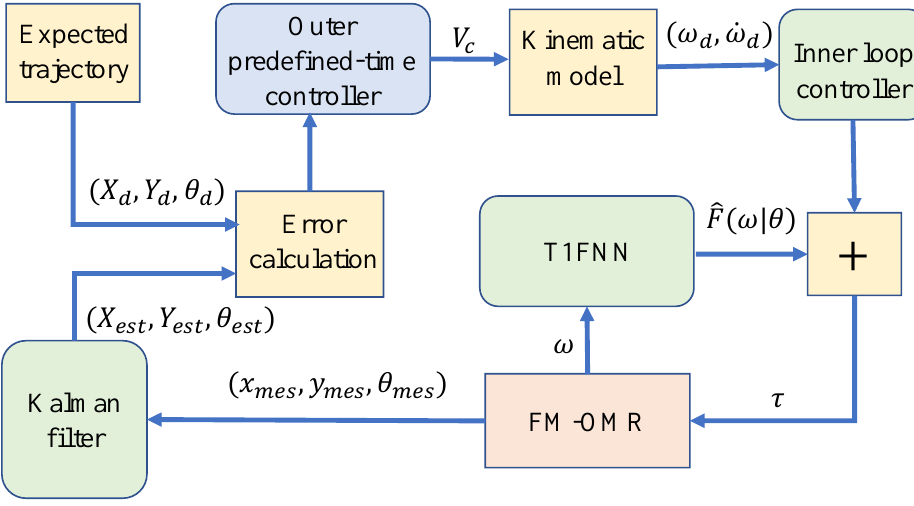
Figure 3. Control structure